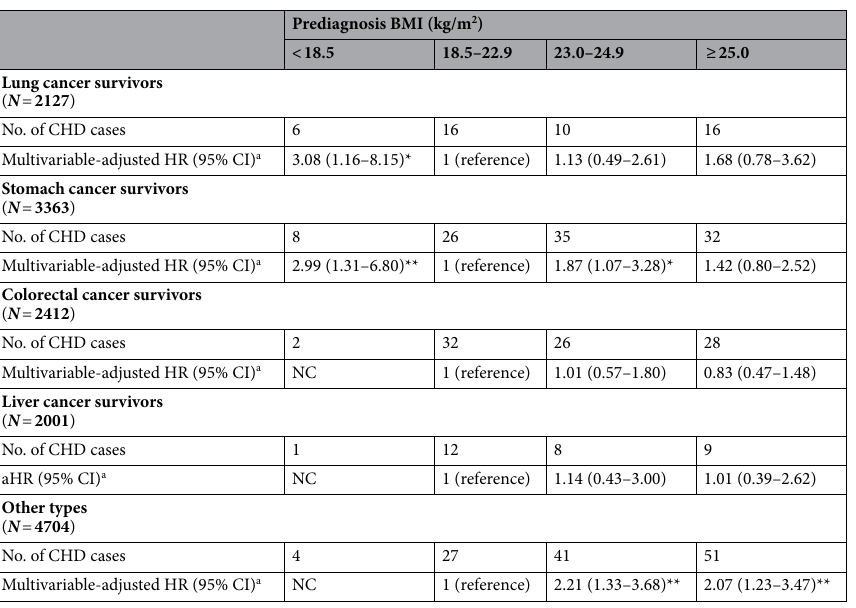
Table 3. Hazard ratios for coronary heart disease (CHD) among cancer survivors according to prediagnosis body mass index (BMI) stratified by first site of cancer at enrollment. Data above are presented in numbers, HR, and HR (95% CI). HR hazard ratio, CI confidence interval, NSAIDs non-steroidal anti-inflammatory- drugs, NC not calculable. a Adjusted for socioeconomic factors (age, sex, residential area, insurance premium), lifestyle (smoking status, alcohol consumption, and physical activity), medical characteristics (fasting serum glucose, total cholesterol, blood pressure, and Charlson comorbidity index), family history (cardiovascular disease), depression, and medication use (aspirin, statin, anti-hypertensive drugs, anti-diabetic drugs, and NSAIDs). * p < 0.05, ** p < 0.01, *** p <